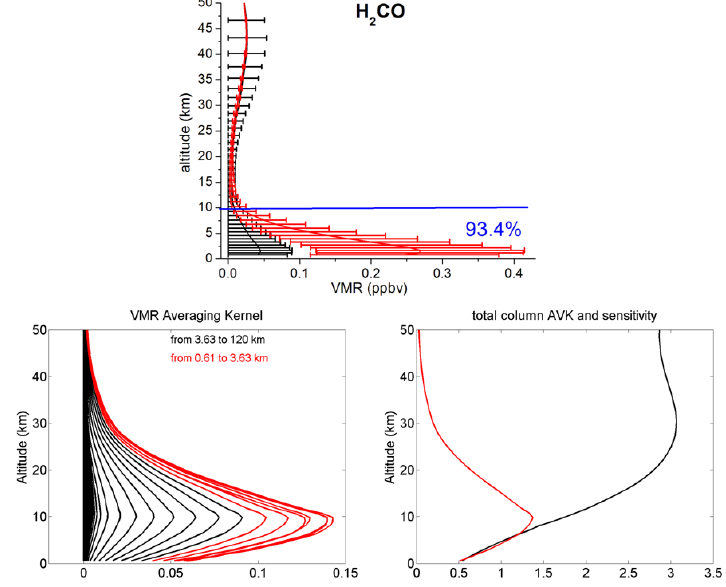
Figure 9. Same as Fig. 3 but for H 2 CO. The H 2 CO a priori VMR profile is from WACCM v6 and divided by 2.